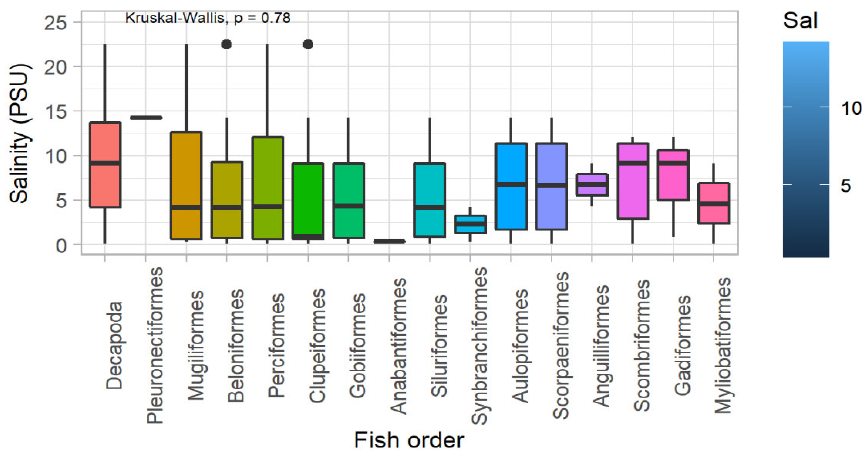
Conservation 2022 , 2 , FOR PEER REVIEW 12